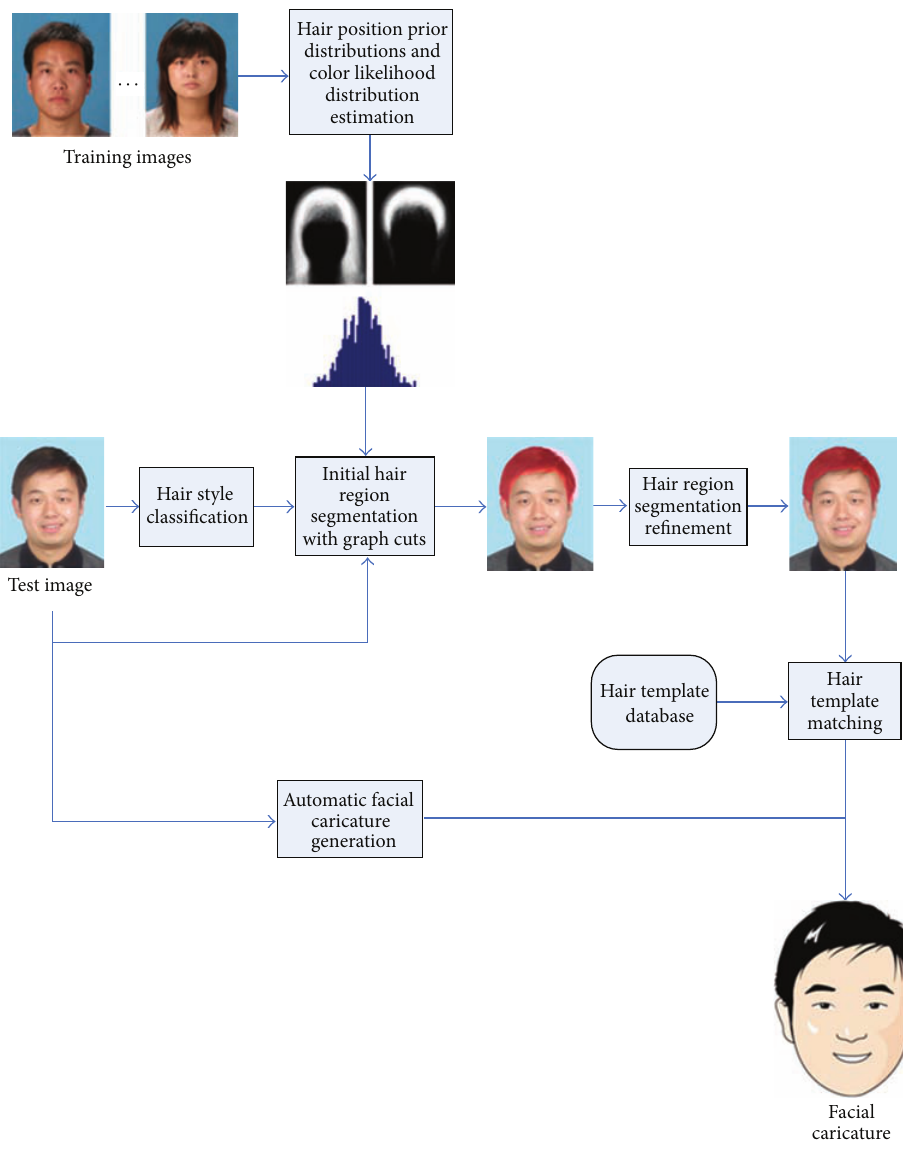
Figure 1: Workflow of our proposed